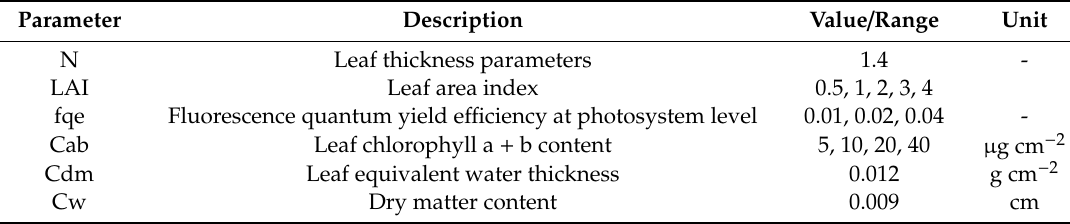
Table 2. Main input parameters for the Soil Canopy Observation Photosynthesis and Energy (SCOPE) model simulations.